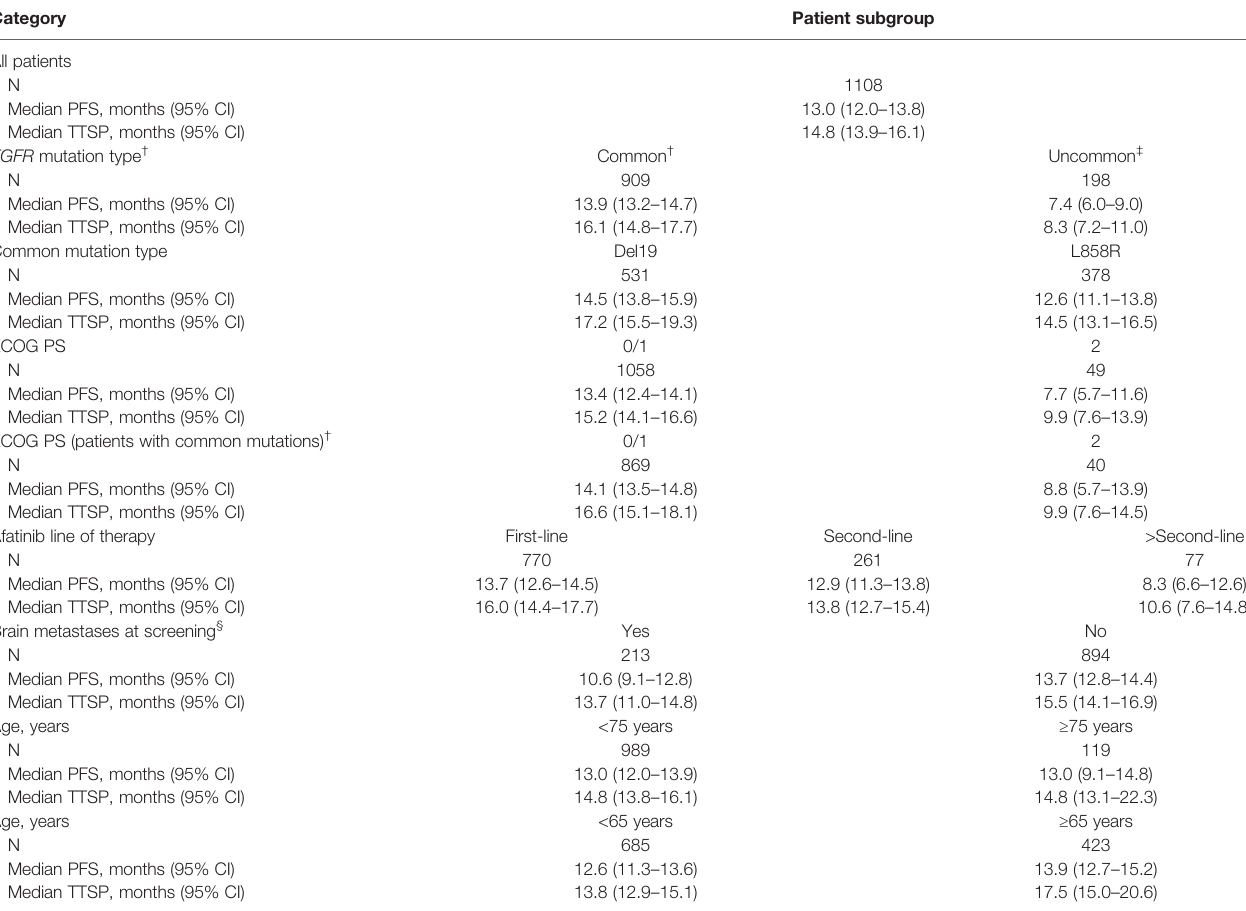
TABLE 3 | Post-hoc analysis of TTSP and PFS for speci fi ed subgroups. Category Patient subgroup All patients